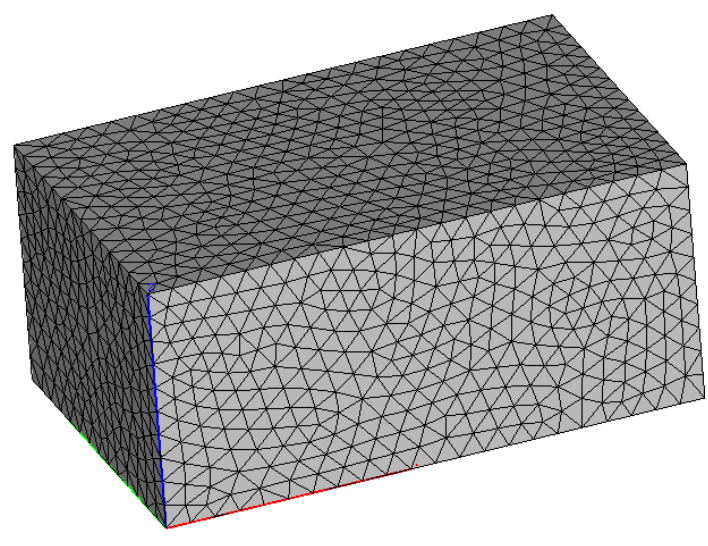
Figure 3. The finite element model of the cavity.